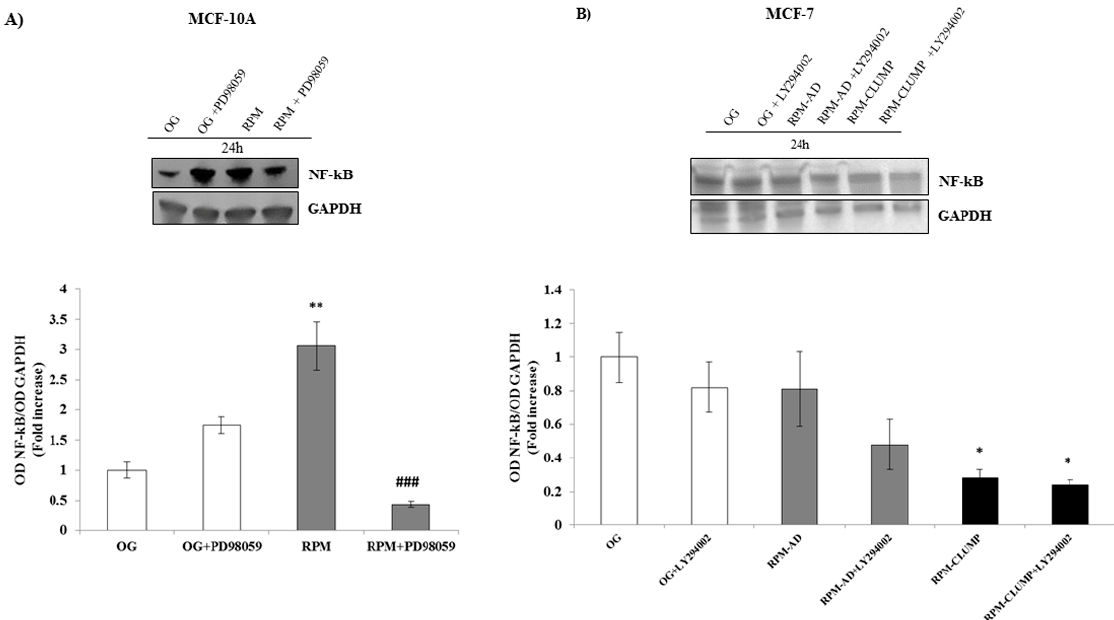
Figure 16. Immunoblot bar chart showing the expression of NF-kB in MCF-10A ( A ) and in MCF-7 ( B ) in on-ground control cells, RPM adherent cells, and RPM cell clumps at 24 h w/o the p-ERK inhibitor, PD89059, and w/o the p-AKT inhibitor, LY294002, respectively. Columns and bars represent densitometric quantification of the optical density (OD) of a specific protein signal normalized with the OD values of the GAPDH serving as the loading control. Each column represents the mean value ± SD of three independent experiments. In MCF-10A, ** p < 0.01 vs. OG; ### p < 0.001 vs. RPM by ANOVA followed by Bonferroni post-test. In MCF-7, * p < 0.05 vs. OG by ANOVA followed by Bonferroni post-test.